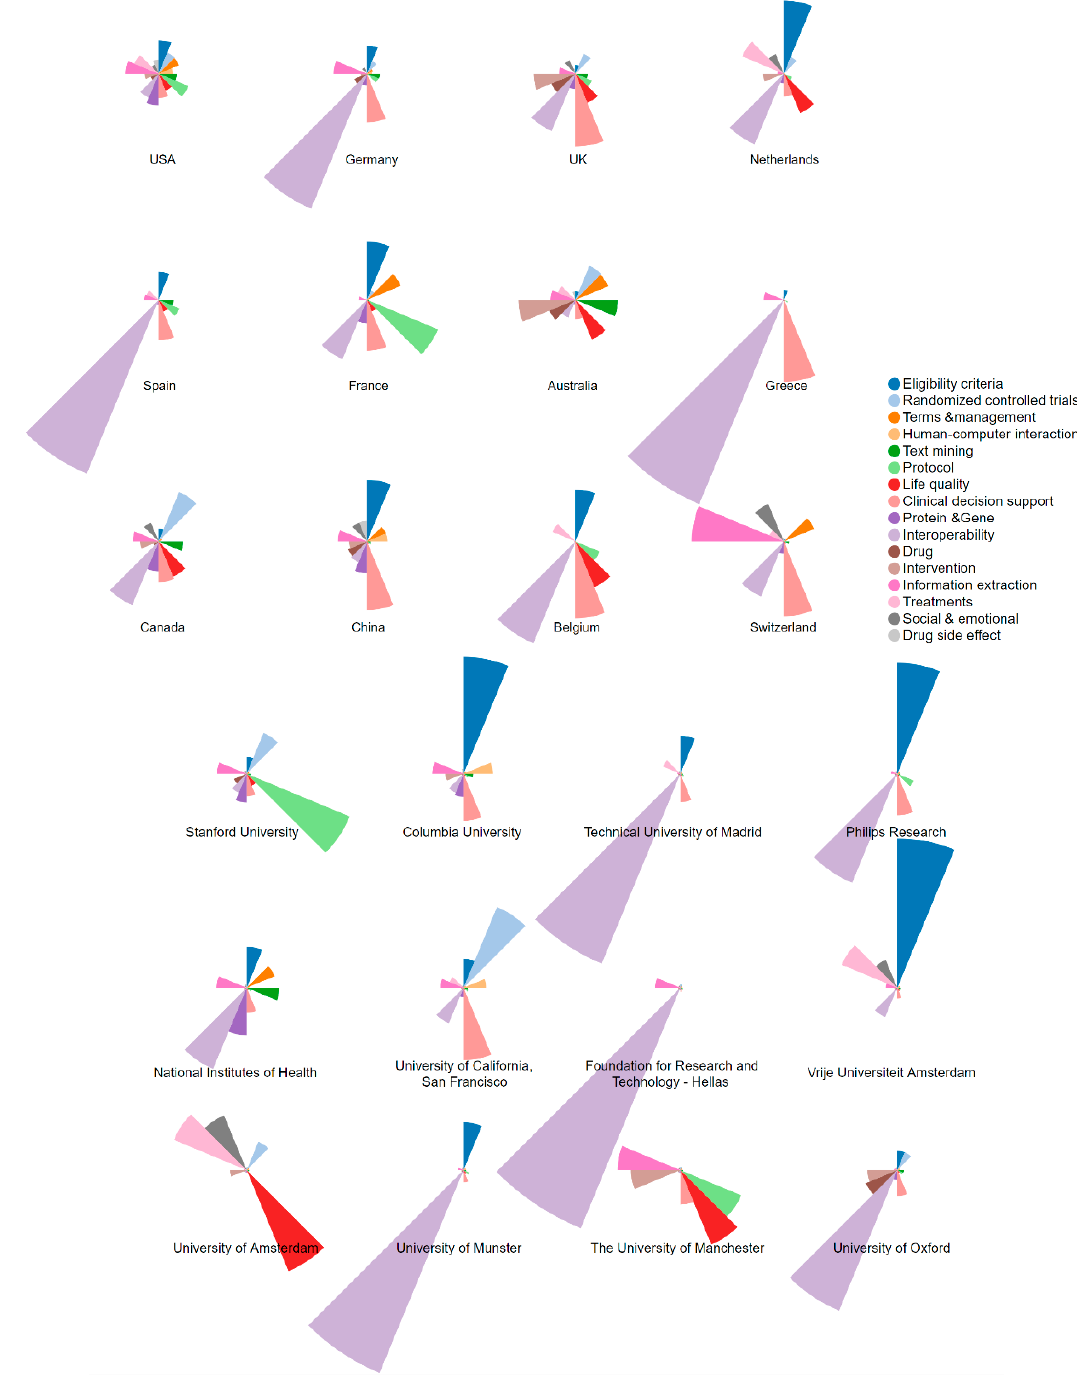
Figure 8. Topic proportion distributions across the prolific countries/regions and institutions.